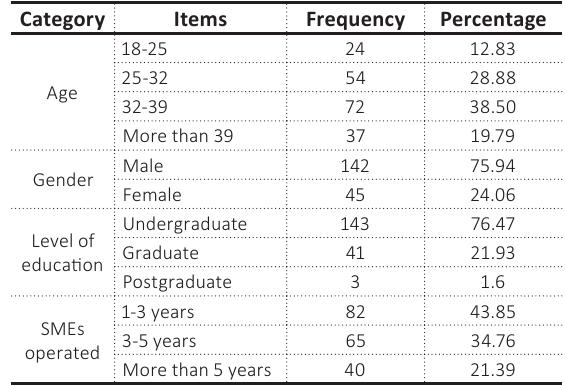
Table 1. Demographics of respondents